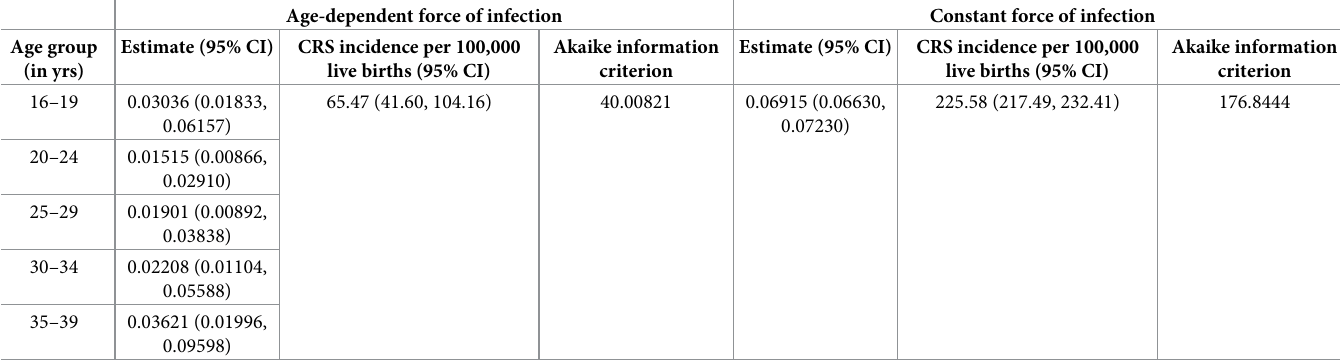
Table 2. Estimates of the force of infection based on constant and age-dependent catalytic models.